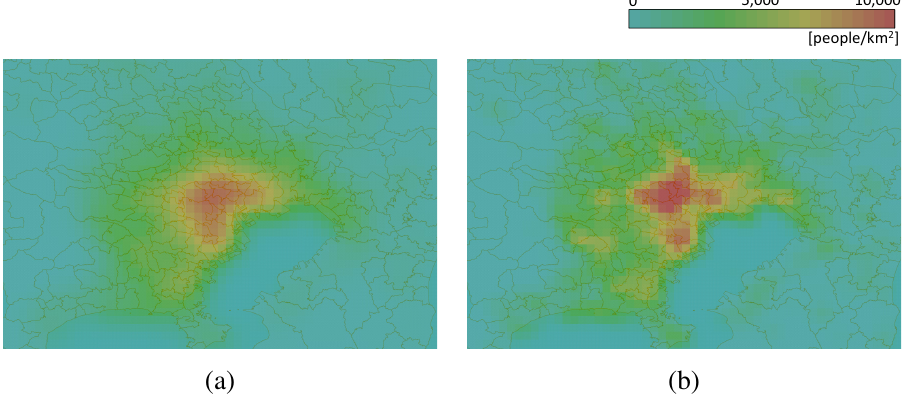
Figure 9. Visualized distributions after sub-sampling (7:00 a.m.). ( a ) Quadratic-kernel estimator ( h = 1.0); ( b ) Gaussian-kernel